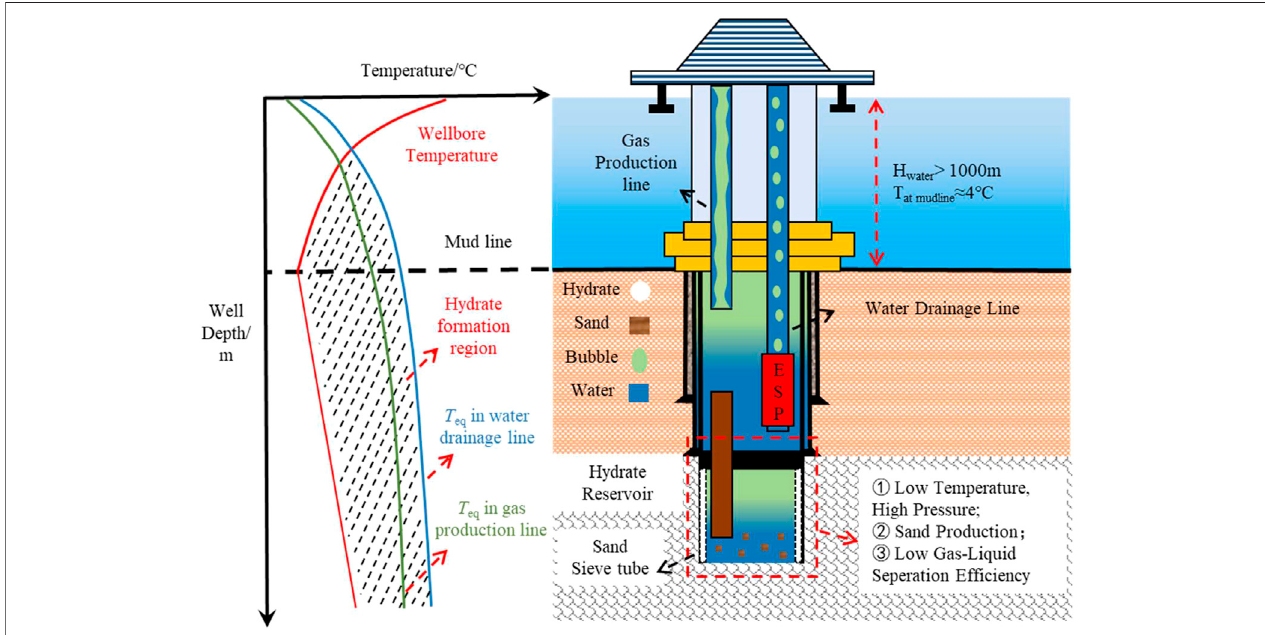
FIGURE 1 | Hydrate formation region in the water drainage line and the gas production line for the pilot production of natural gas hydrates.